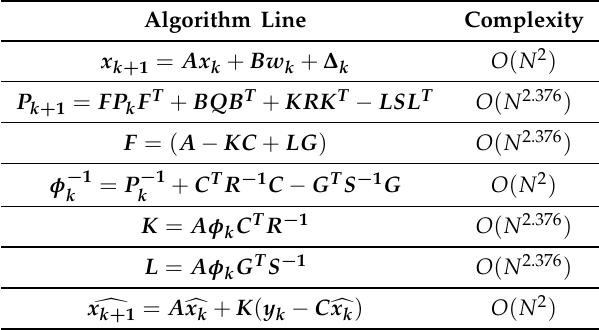
Table 3. Computational complexity of the minimax